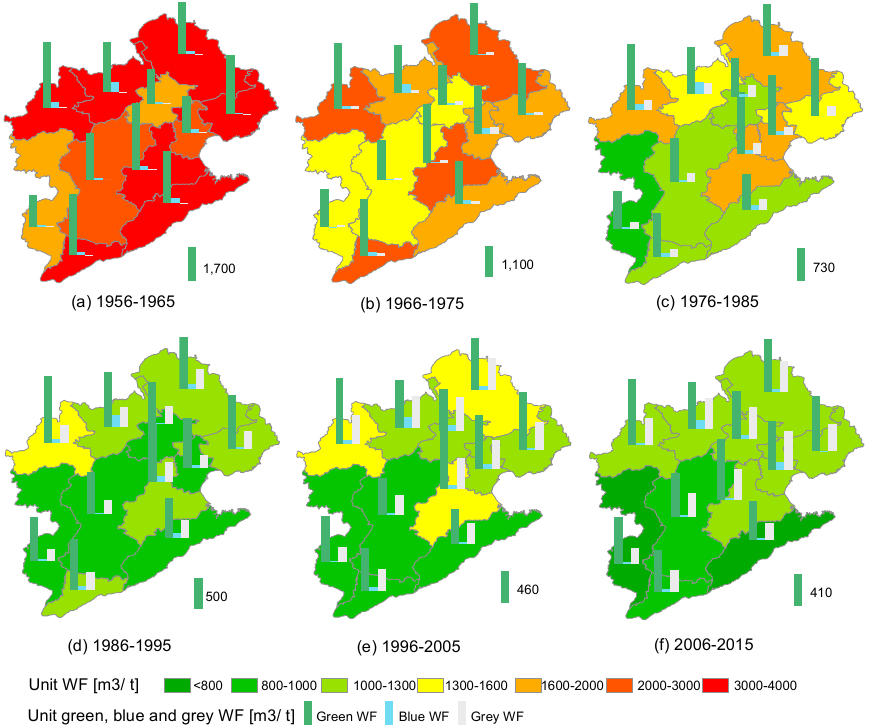
Figure 7. Unit WF of maize in the HRB over 1956–2015 (m 3 t –1 ).